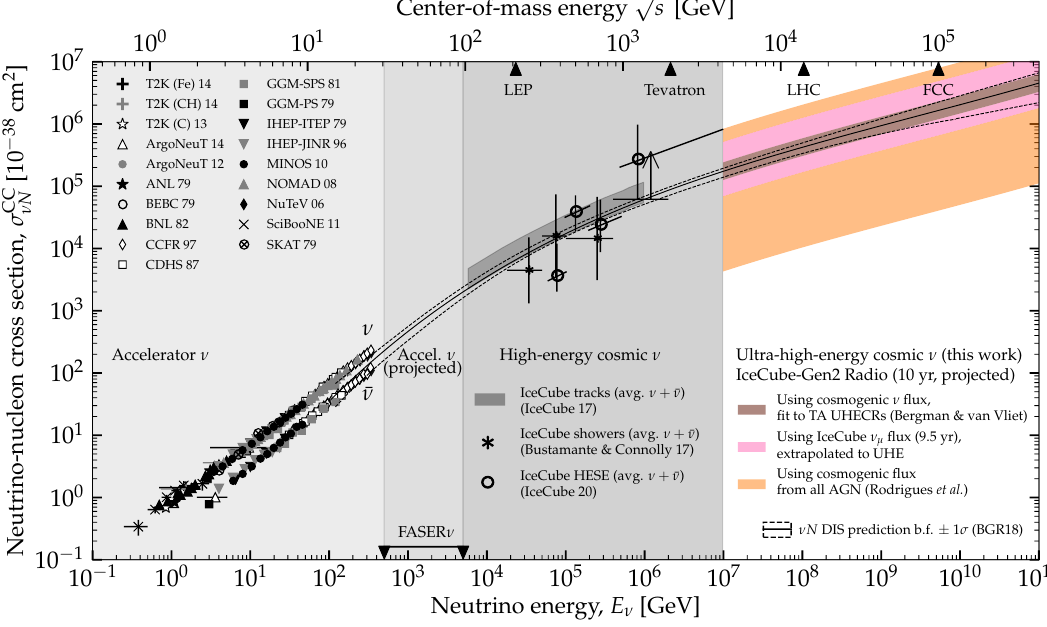
Figure 1 . Neutrino-nucleon ( νN ) charged-current (CC) cross section, measurements and predictions. Sub-TeV measurements are from accelerator-neutrino experiments [1–18]. Few-TeV measurements will be covered by the upcoming FASER ν accelerator-neutrino experiment [19]. TeV–PeV measurements use high-energy astrophysical neutrinos detected by the IceCube neutrino telescope [20–22]. We forecast cross-section measurements above 100 PeV — the ultra-high-energy (UHE) range — where no measurement exists presently. Our forecasts are for radio-detection of UHE neutrinos in the planned IceCube-Gen2 [39], and are based on sophisticated simulations of UHE neutrino